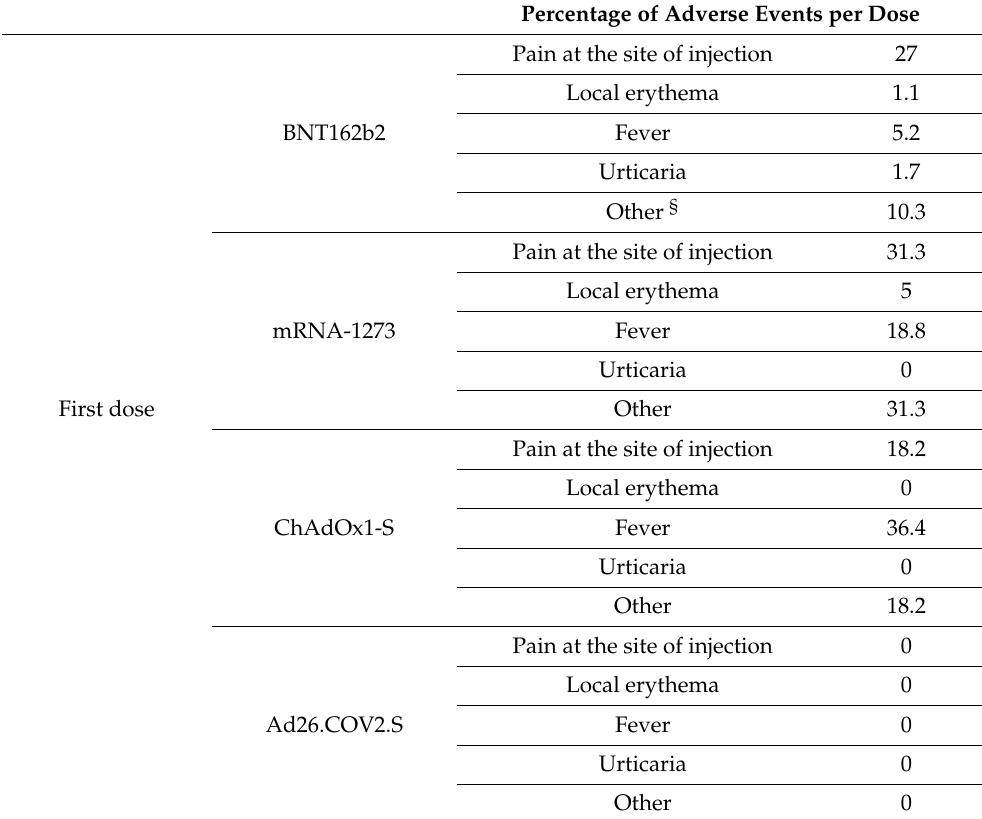
Table 8. Percentages of adverse reactions following each vaccination